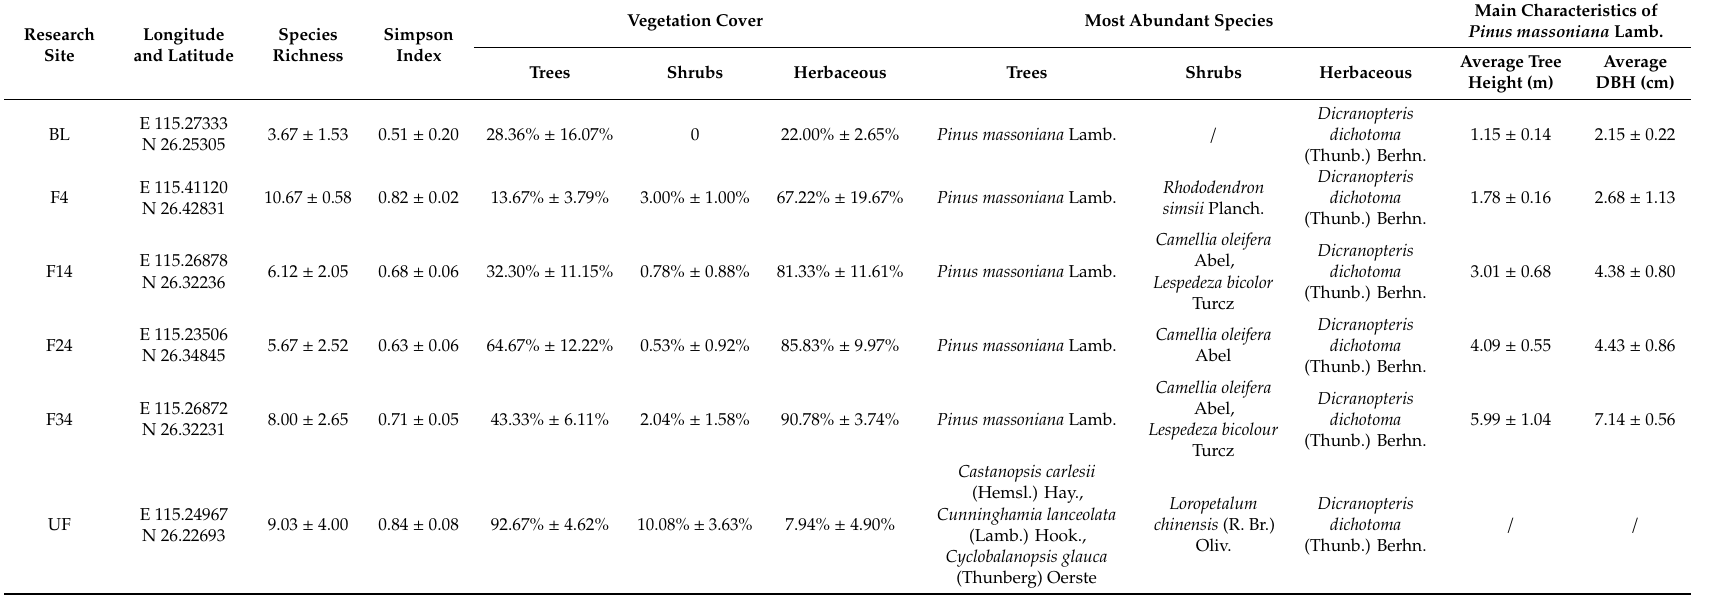
Table 1. Summary of the vegetation characteristics of the six research forest sites. Data are mean ± SD.